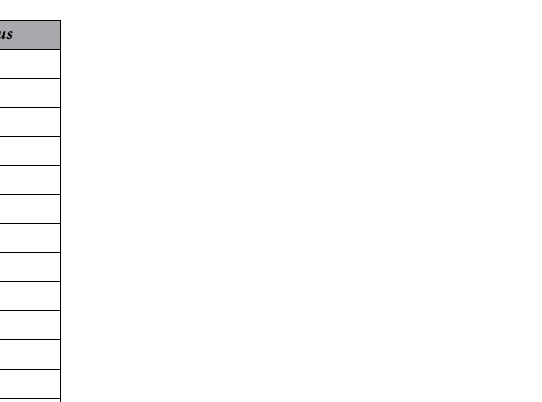
Table 1. Genes induced by E . coli and S . aureus infection. PNG, peptidoglycan; INFG, interferon γ ; P38, p38 mitogen-activated protein kinases.